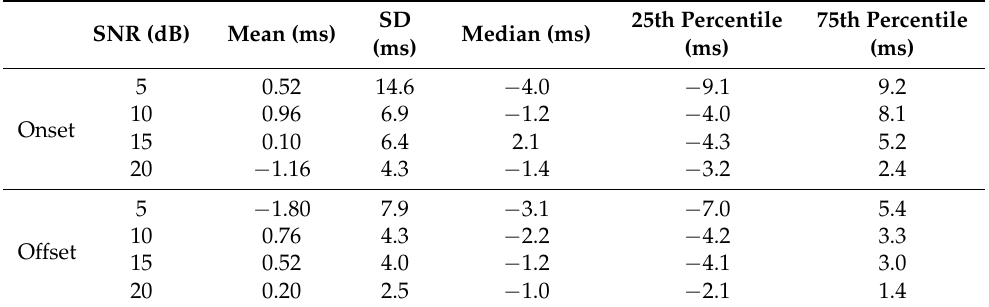
Figure 3. Two-dimensional color representation of CWT scalogram function for two simulated sEMG signals ( A , B ). ( C ) shows the CWT coscalogram between the simulated sEMG signals in ( A , B ). The accuracy in predicting the co-contraction onsets and offsets in the whole dataset of the simulated sEMG signals was 100%. This means that the proposed CWT approach was able to identify all the simulated co-contraction intervals (recall = 100%) and that no false positives were detected (precision = 100%). The prediction errors for the co-contraction onset and offset were quantified in terms of AE and TD. The mean, SD, median, 25th percentile, and 75th percentile for each SNR value are depicted in Figure 4 and further reported for the TD in Table 1. The AE values decreased with an increase in the SNR from 5 to 20 dB. The mean and median TD values for both the onset and offset fell in the [ − 5 ms; 5 ms] range for all the SNR values. The AE values computed for SNR = 5 dB were significantly higher ( p < 0.05) than all the AE values computed in the other three SNR conditions for the detection of both the onset and offset instants of the co-contraction. Table 1. Time delay (TD) ± SD computed over simulated sEMG co-contractions per SNR value, expressed in